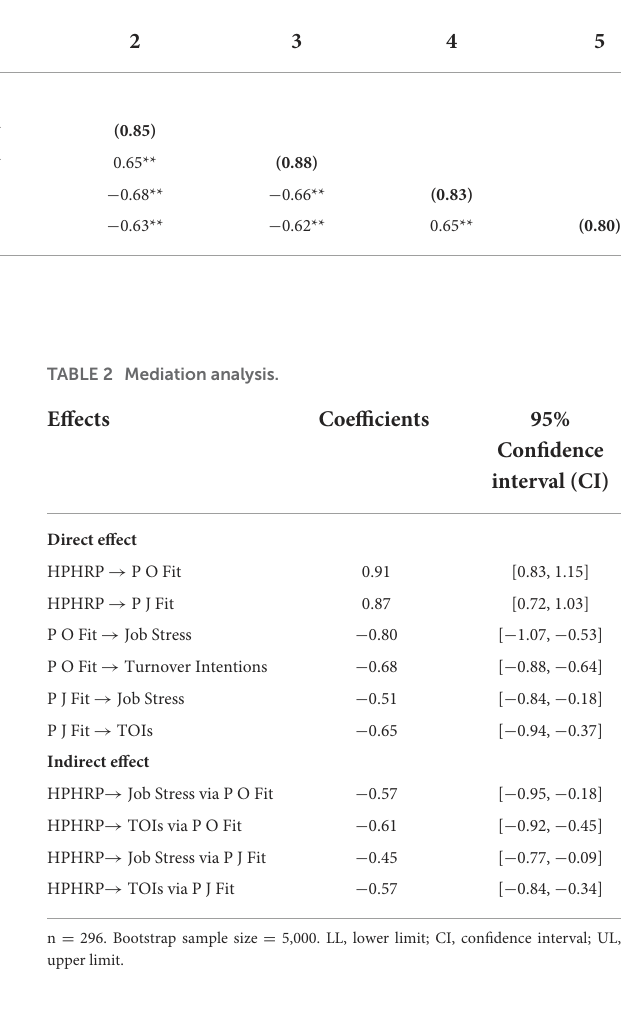
TABLE 1 Correlation, descriptive statistic, and reliability.